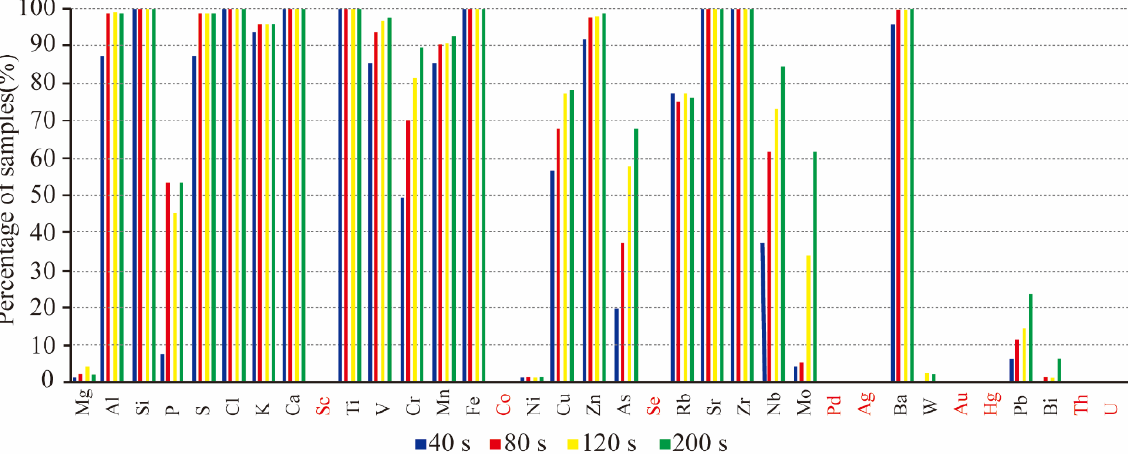
Figure 3. The percentage of rock powder samples in which an element can be detected by pXRF based on different detection times.